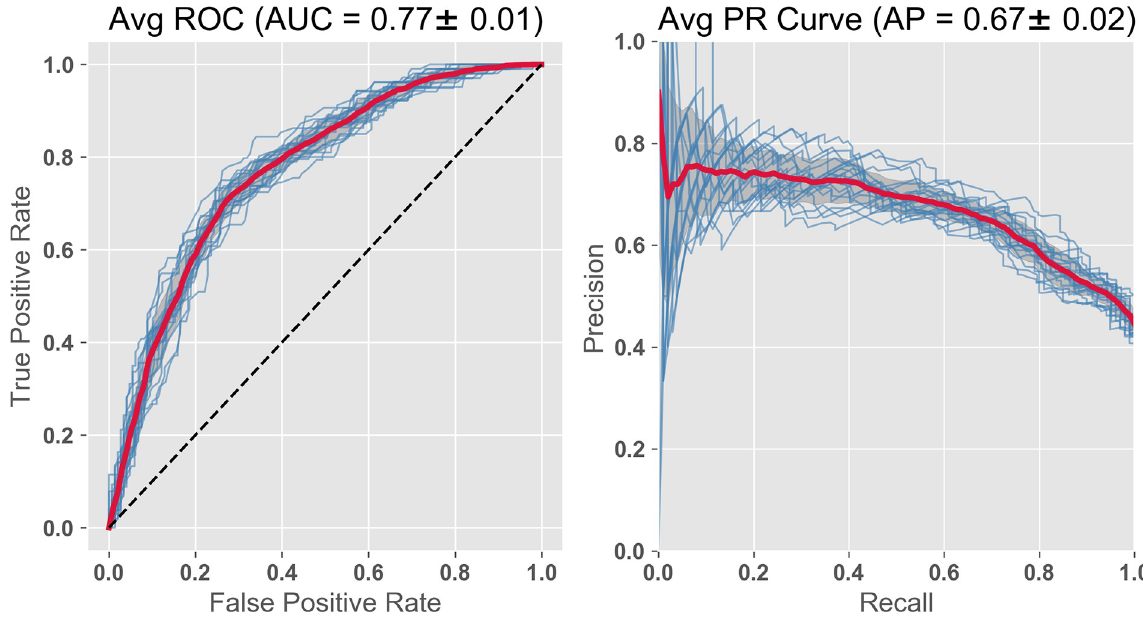
Fig 7. Further AUC ROC improvement is seen combining pBM, MRI, cognitive scores, atrophy rate and demographics. To the features used in Fig 6, we add 19 atrophy features (APC), estimates of annual % change. This improves the AUC from 0.75 to 0.77. The specific MRI regions of interests used to generate atrophy variables are shown in Table 3 where provided is the ADNI code, the neuroanatomical name, and GINI coefficient weighting.